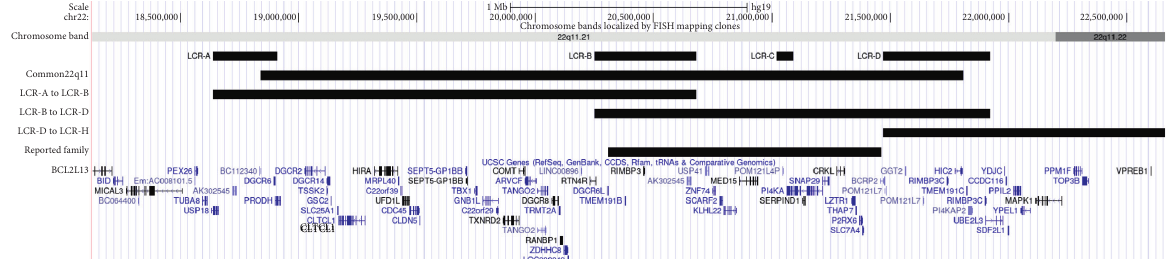
Figure 1: Illustration of the chromosome 22q11.2 region including the genes located in this region and the position of low copy repeats (LCRs). Also, the common and atypical 22q11.2 microdeletions are illustrated as well as the microdeletion identified in the reported family. The positions of the LCRs are depicted as reported in a previous study [1].The illustration is made in the UCSC genome browser (hg19 assembly)